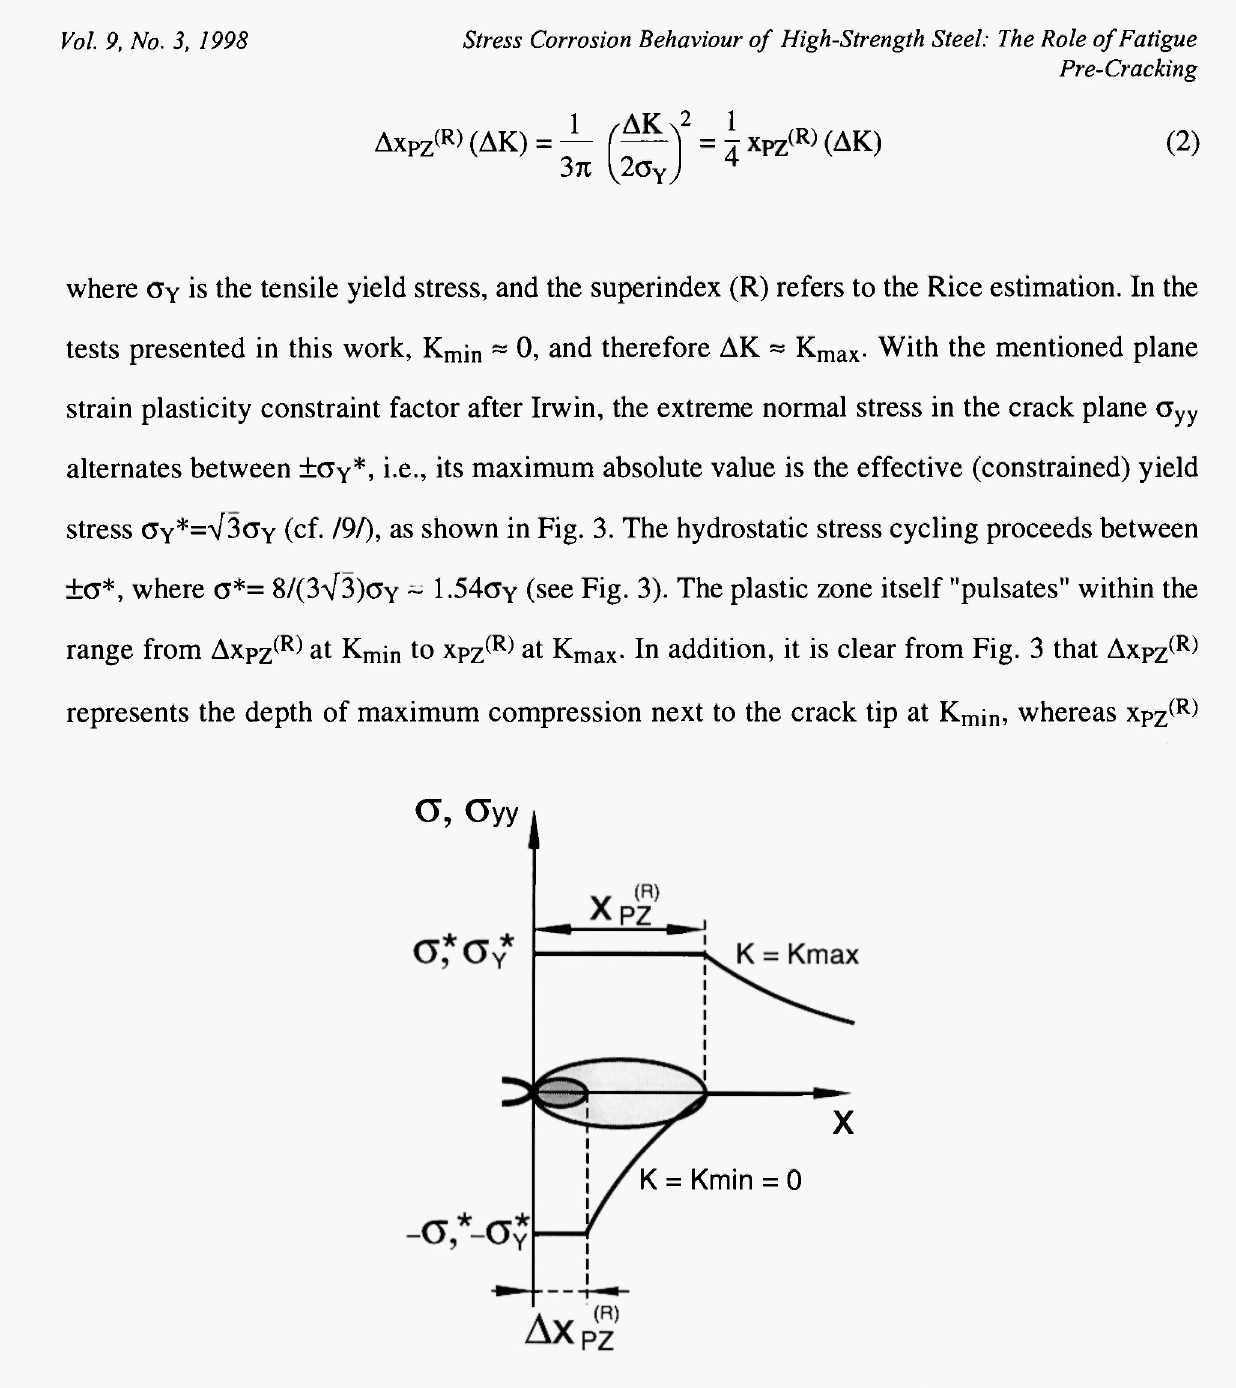
Fig. 3: Monotonie (for K=K x) and cyclic (for K=K i =0) stress distributions ahead of a ma m n crack tip which has been subjected to cyclic zero-to-tension loading, according to the Rice model for an elastic ideally plastic material /8/. The schema shows the distributions of both hydrostatic stress σ and uniaxial stress a (normal to the crack yy plane) and their maximum levels. The forward (or monotonic) plastic zone is lightly shadowed, whereas the reversed (or cyclic) plastic zone is densely